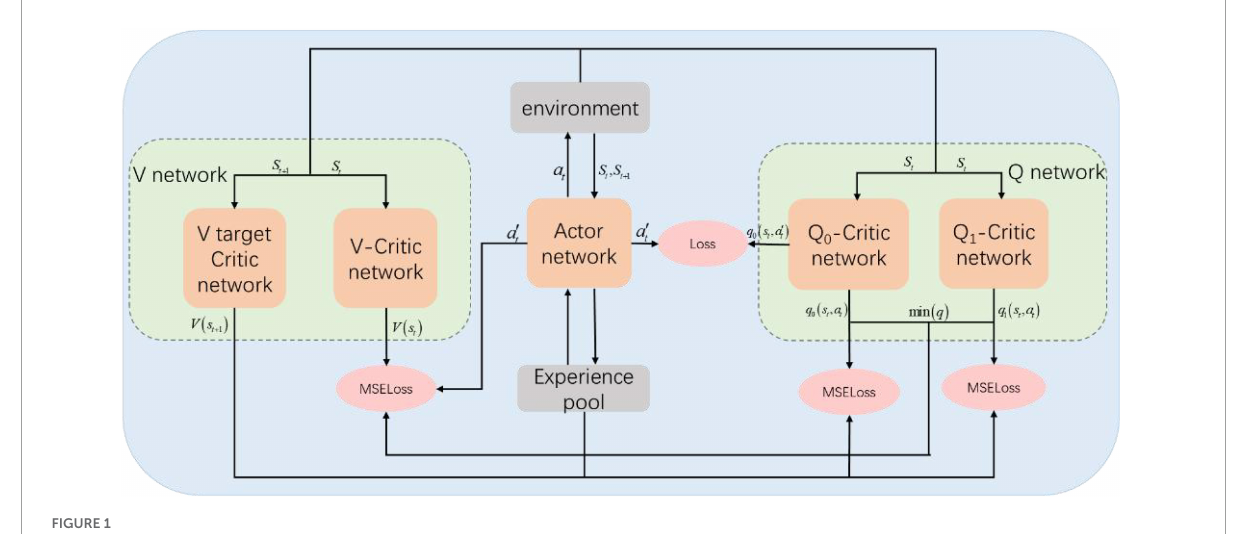
FIGURE1 SAC algorithm network architecture.